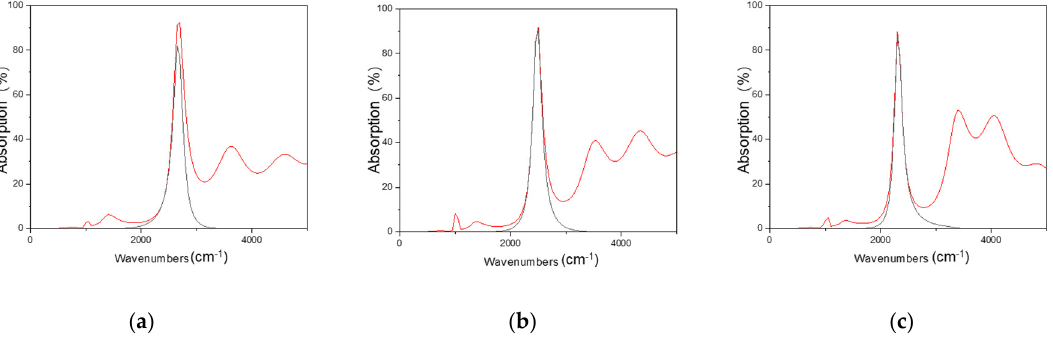
Figure 3. Spectral absorption of photodetectors with resonant cavities constructed from narrowband (HgSe, black line) and broadband (red line) optoelectronic materials at optical spacer layer thicknesses of 0.6 ( a ), 0.8 ( b ), and 1.0 ( c ) µm.